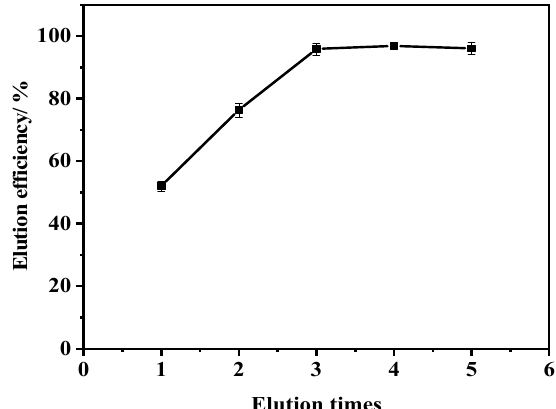
Figure 5. Isothermal adsorption of MIP@SiO 2 @QDs ( a ) and NIP@SiO 2 @QDs ( b ).